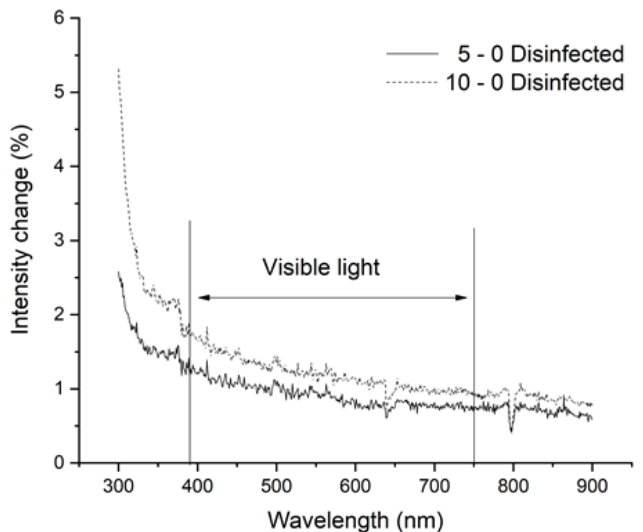
Figure 6. Results of spectrophotometry. The measurements were performed between 300 and 900 nm wavelength. The threshold of visible light is indicated. The changes in intensity have been visualized (%), where the smooth line marks the results of test samples after five cycles, and the dotted line represents the test samples after 10 cycles. The values of intensity are subtracted from the baseline, which was determined using non-disinfected samples.